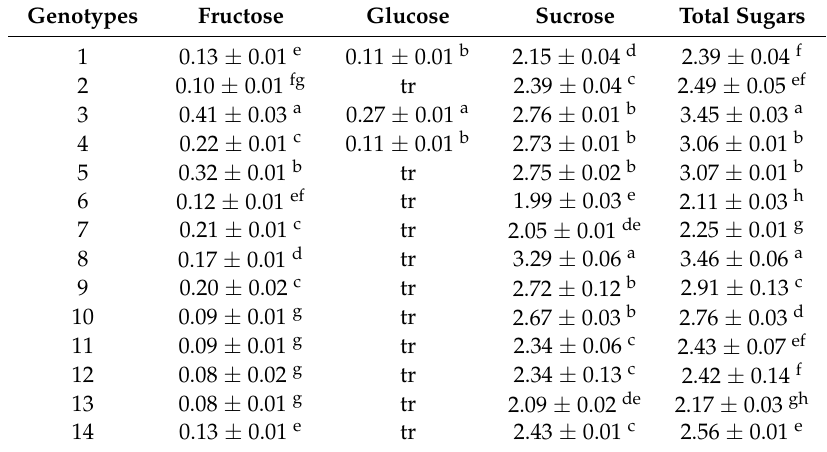
Table 6. Free sugars of the studied garlic genotypes (g/100 g f.w.; mean ± SD; n =